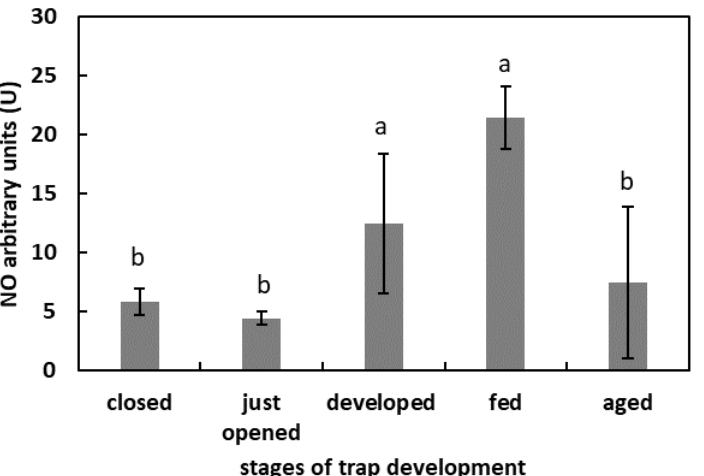
Figure 4. NO generation in digestive fluid in the traps at different developmental stages: closed, just opened, developed, fed (one day after feeding), and aged. Values are average ± SD of 3 repetitions. Letters ( a , b ) indicate homogenous groups determined after ANOVA and post hoc Fisher ’ s LSD test at p ≤ 0.05.